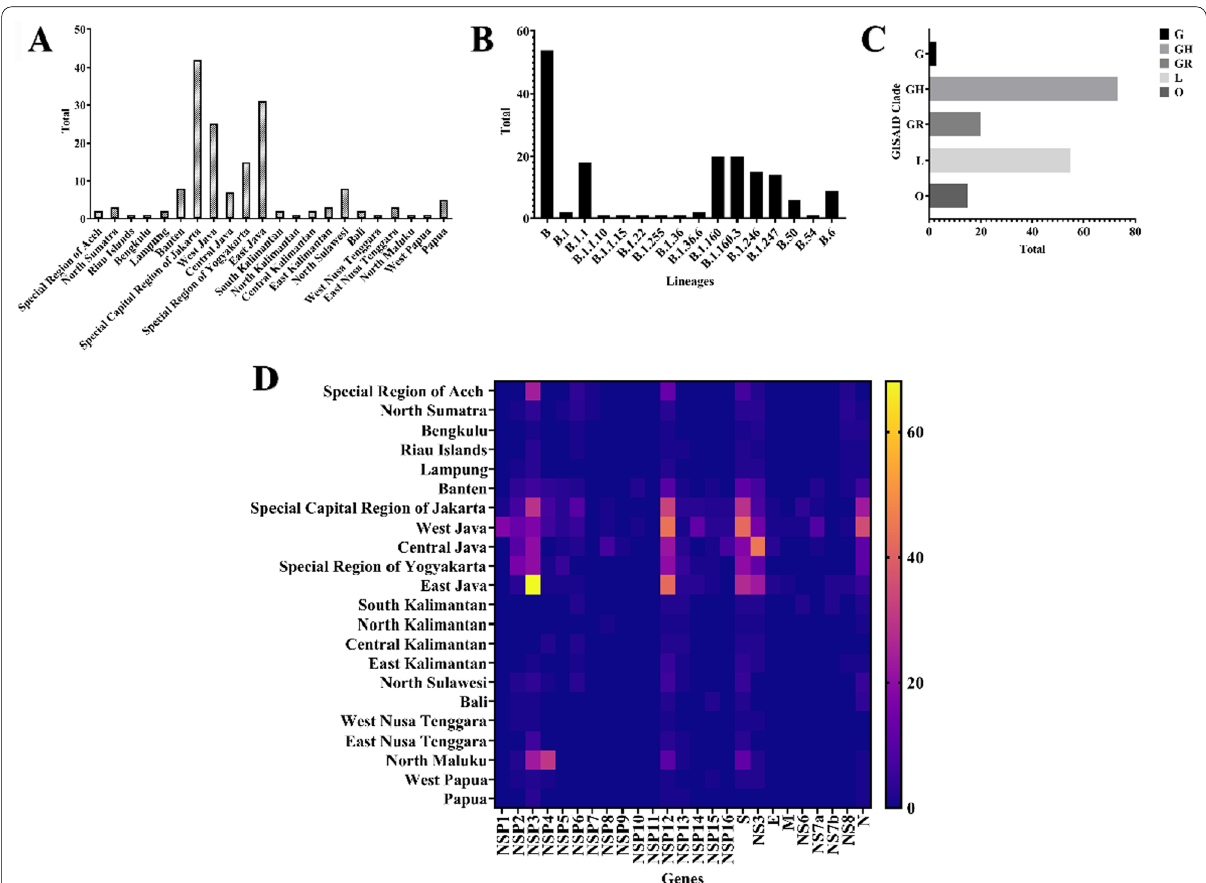
Fig. 1 All Indonesian SARS-CoV-2 isolates data. A The origin of isolates; B the lineages distribution of the isolates; C the GISAID EpiCoV clades; and D the full-length genome mutation analysis of all isolates used in this study. All data were visualized using GraphPad Prism